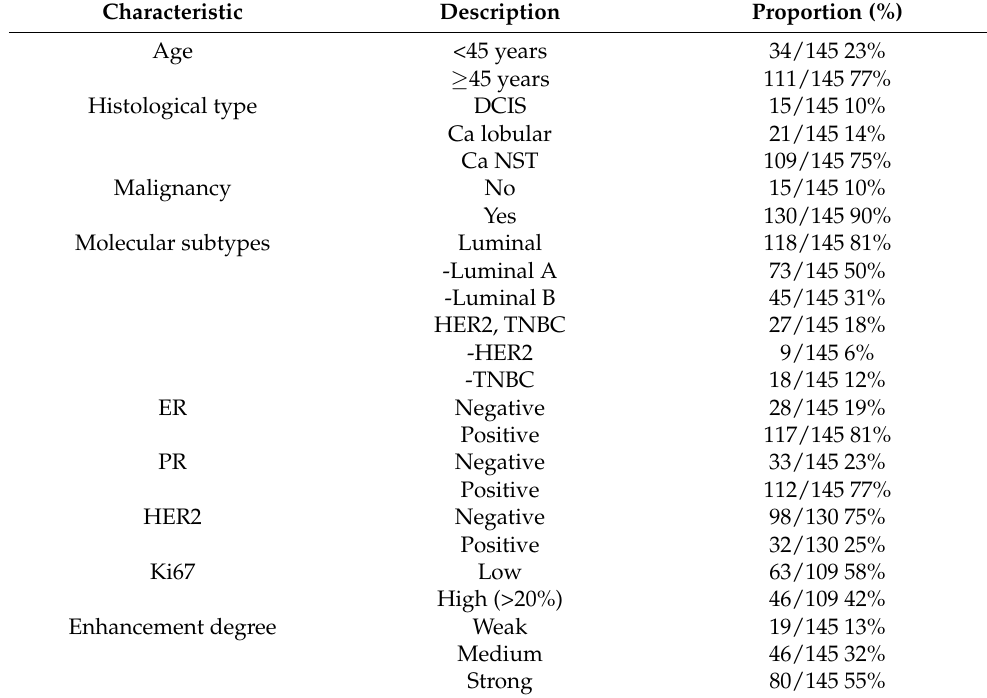
Table 1. Clinicopathological characteristics of the lesions and patients (abbreviations: estrogen